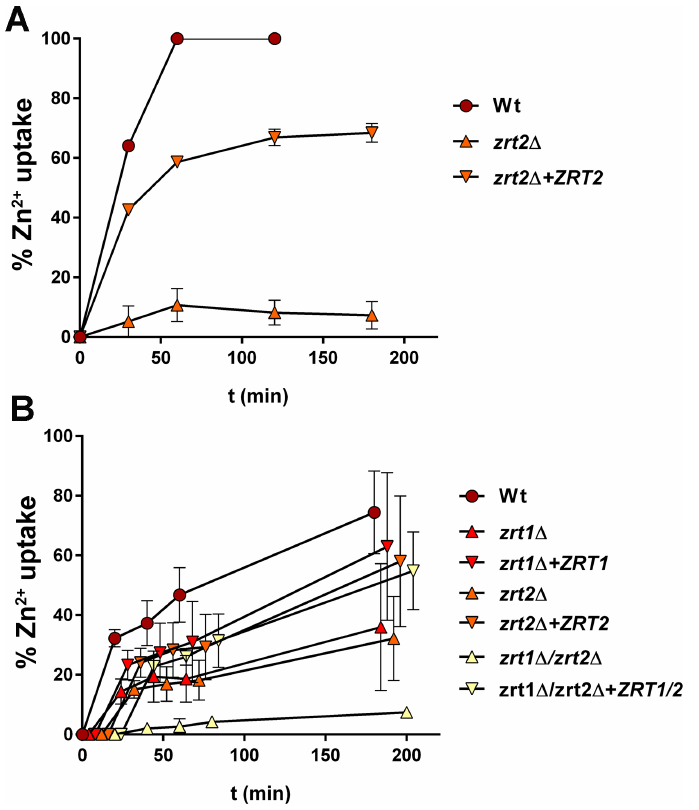
Fig 2. Zinc uptake by C . albicans is mediated by Zrt1 and Zrt2. ( A ) Indicated strains were cultured in low zinc medium (SD0, pH ~4.7), exposed to 25 μ M ZnSO 4 and zinc acquisition determined at indicated time points by measuring how much zinc remained in the cell free supernatant. C . albicans wild type acquires all measurable zinc within 60 minute; zrt2 Δ does not; complementation restored zinc acquisition to 68%. Experiment performed three times ( B ) Indicated strains were incubated in RPMI without zinc for 24 h, exposed to 25 μ M ZnSO 4 and zinc acquisition determined as in panel A. Wild type cells acquire 74% of zinc by three hours; uptake is reduced by approximately 50% in zrt1 Δ and zrt2 Δ . zrt1 Δ / zrt2 Δ fails to take up zinc. Experiment performed twice. Data points have been shifted to the right to make them visible amongst